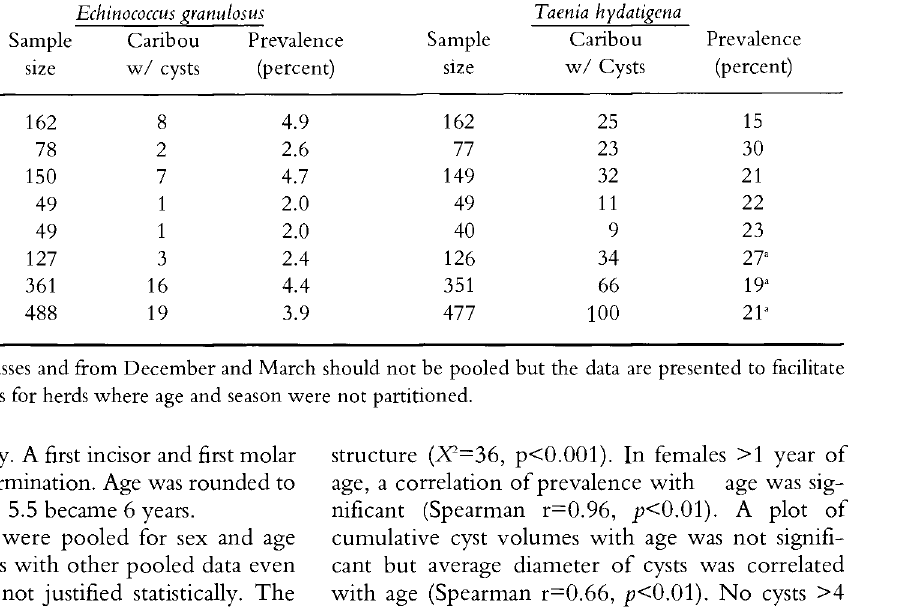
Table 1 Prevalence of lung and liver cysts in caribou sampled from the Beverly herd from March 1985 - 1987. Echinococcus granulosus Taenia hydatigcna